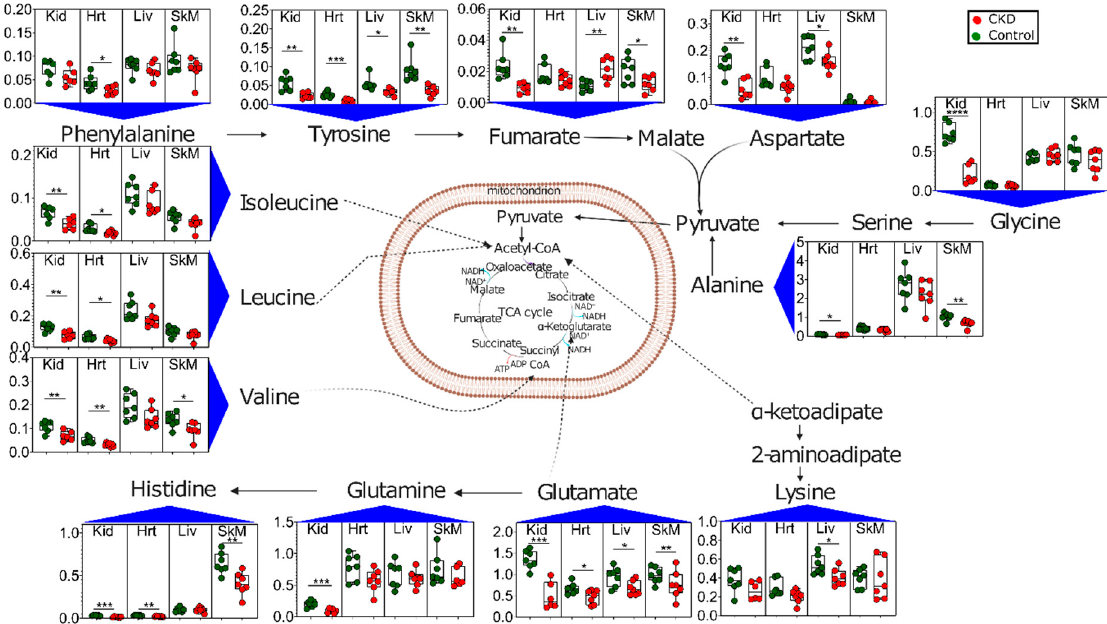
Figure 7. Altered amino acid metabolism in CKD. Graphical depiction of amino acid catabolism with quantified metabolites presented as Box and Whisker plots (showing 95% confidence intervals) in control (green dots) and CKD mice (red dots). The y -axis values represent metabolite concentrations in units of millimolars. A two-tailed unpaired t -test was performed to determine the statistical significance, with * p < 0.05, ** p < 0.01, *** p < 0.001, and **** p < 0.0001 ( n = 7/group/tissue). Abbreviations: Kid = kidney, Hrt = heart, Liv = liver, and SkM = skeletal